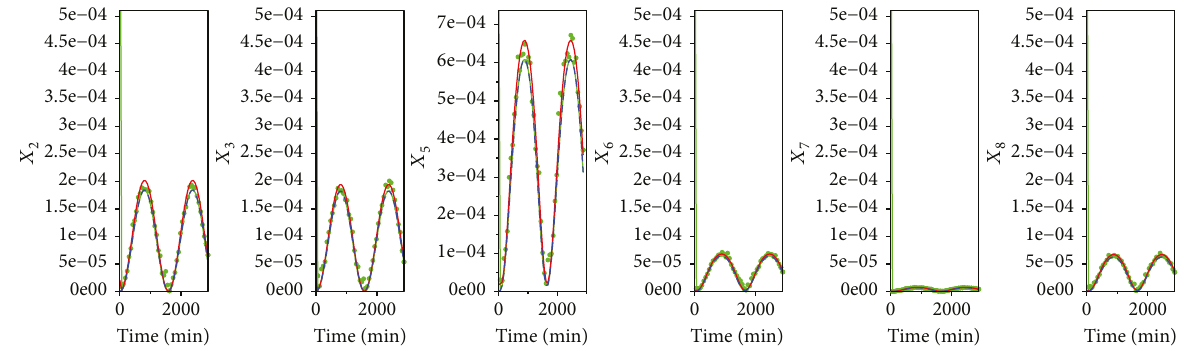
Figure 5: Zoom on the concentration of metabolites in QSS in Figure Table 3: Parameters considered for the simulations in Figure 4. Table 4: Slow and fast reaction rates considered for the toy network The symbol γ ∈ − 1, 1 denotes a rate in an enzymatic reaction in Figure 3 and the simulations in Figure 4. Fast reaction rates are characterized by the factor 1/ ε . All reactions rates are in units of (see the Michaelis-Menten equation (A.1)). The initial conditions g(L · min) − 1 . for all the enzymes are the same, as well as the initial conditions of all the metabolites are identical, that is, j , i ∈ 1, … , n in this table.